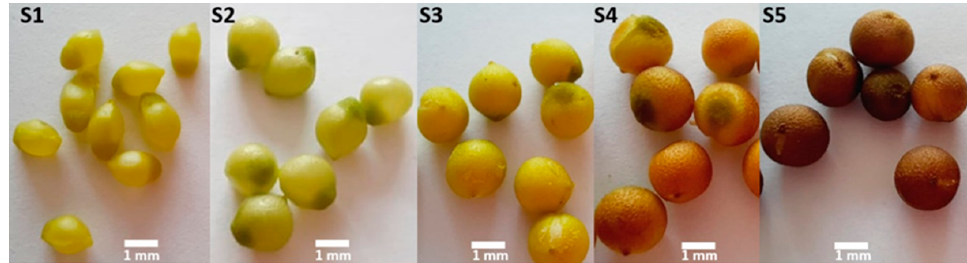
Figure 3. Morphological characterization of distinct seed maturity stages of A. pelegrina . S1: Seed